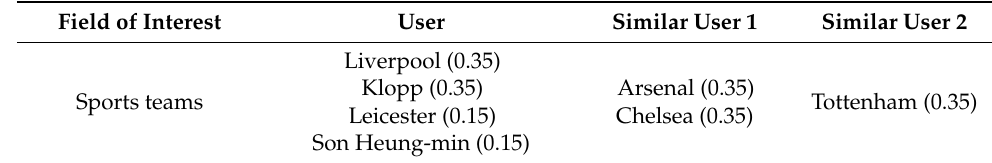
Table 3. User’s preferences and similar users’ preferences in a specific field of